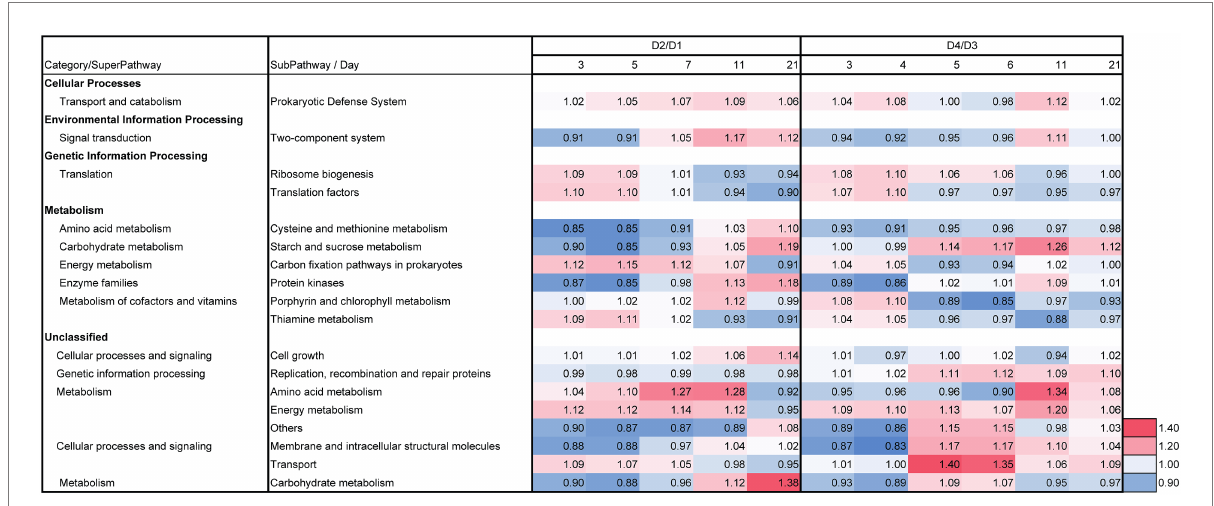
FIGURE 8 Effects of Indigofera tinctoria L. leaf powder (LP) on the ratios (D2/D1 of days 3, 5, 7, 11, and 21; and D4/D3 of days 3, 4, 5, 6, 11, and 21) for each relative abundance of functional subpathway of the bacterial communities in the indigo fermentation using D- sukumo . The batches of I. tinctoria L. leaf powder (LP) added (D2 and D4) and controls (D1 and D3) are shown. Wheat bran was added to batches D3 and D4 on day 4. In addition, the metagenomic prediction produced using PICRUSt2 and BURRITO is shown. Subpathways containing ratios higher than 1.10 were selected in days